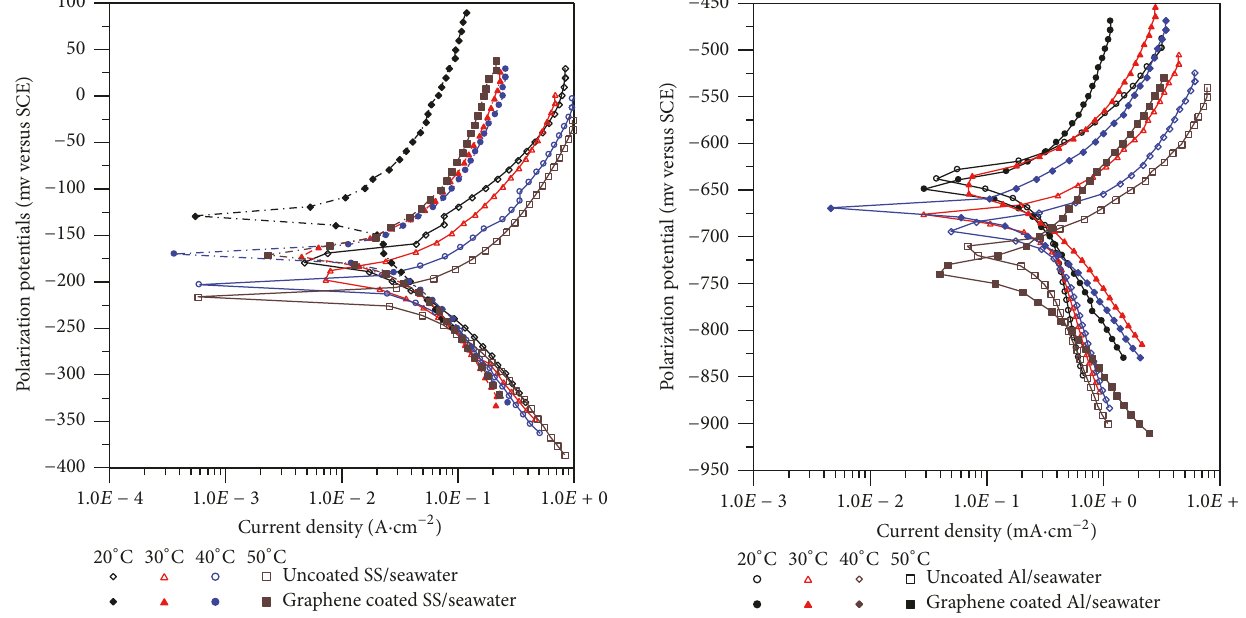
Figure 12: Tafel plots of aluminum specimens in seawater system without and with reduced GO coating at different